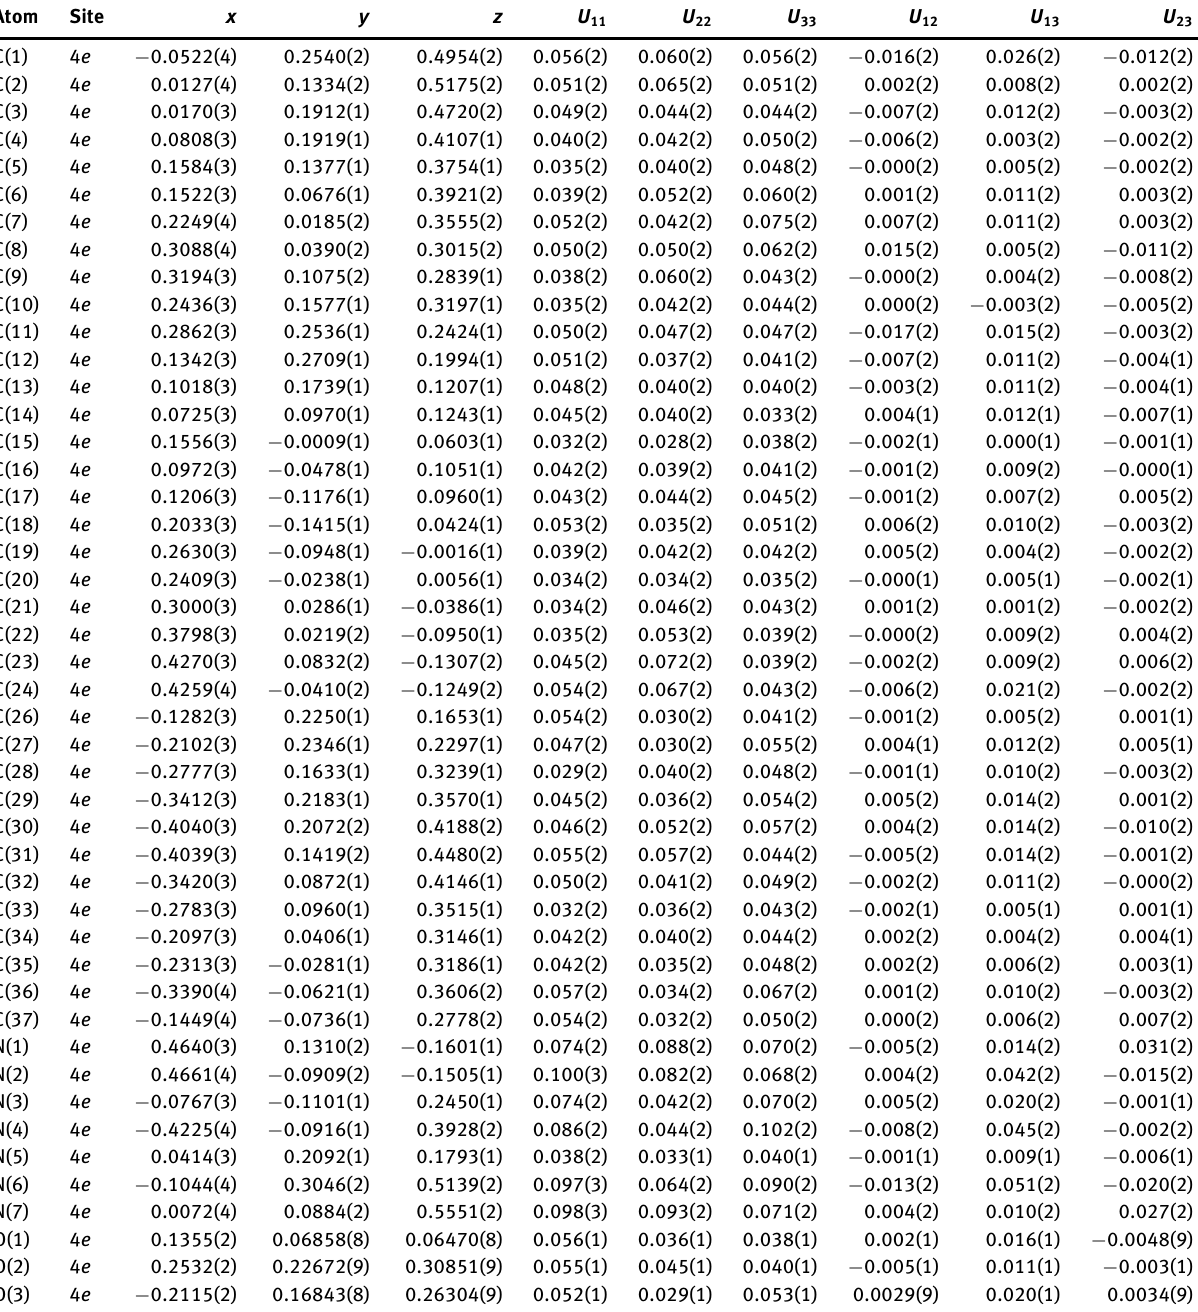
Table 3: Atomic displacement parameters (Å 2